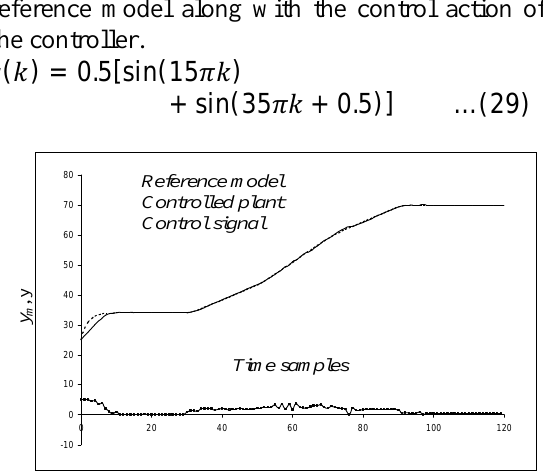
Fig. 7. Outputs of the reference model and the controlled plant when a parameter variation test is applied on Plant 2 objective functions against generations.